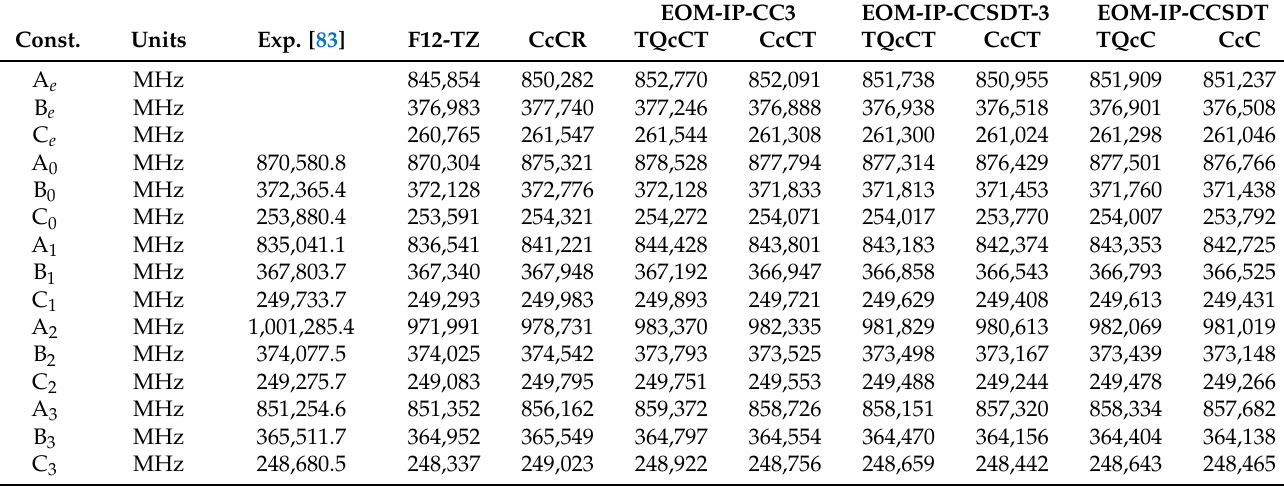
Table 5. ˜X 2 B 1 H 2 O + Rotational Constants in